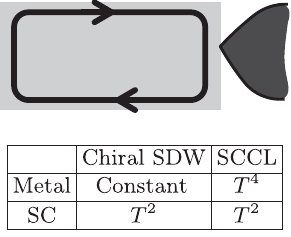
FIG. 16. Top: Point contact measurement with weak tunneling ( G ≪ e 2 =h ) into edge states can distinguish between the CSDW and SCCL phase. Bottom: Temperature dependence of tunneling conductance through point junction between metal or SC lead and CSDW or SCCL, exhibiting different values of power-law exponent α